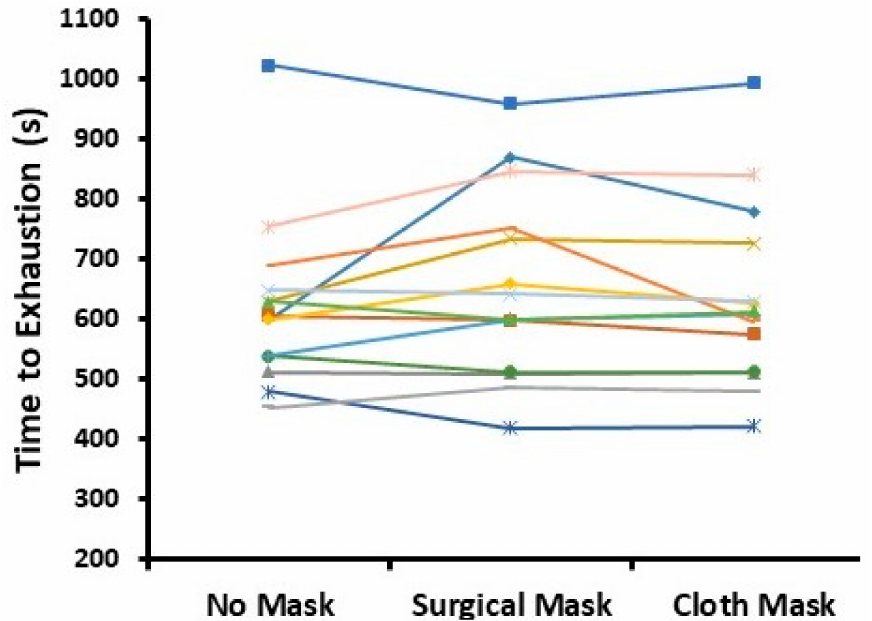
Figure 1. Time to exhaustion during the exercise test for individual participants across conditions. There were no statistical di ff erences between conditions ( p = 0.20).